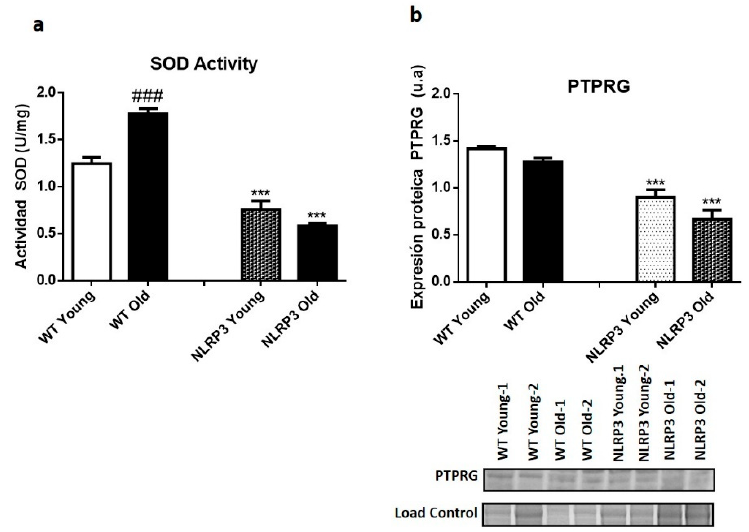
Figure 3. Oxidative stress levels in the liver tissue samples of WT and NLRP3 − / − mice. ( a ) SOD2 activity. ( b ) Protein levels of PTPRG. All data are shown as the means ± SEM ( n = 8). *** p ≤ 0.001 (WT Young / Old vs. NLRP3 Young / Old); ### p ≤ 0.001 (WT Young vs. WT old).